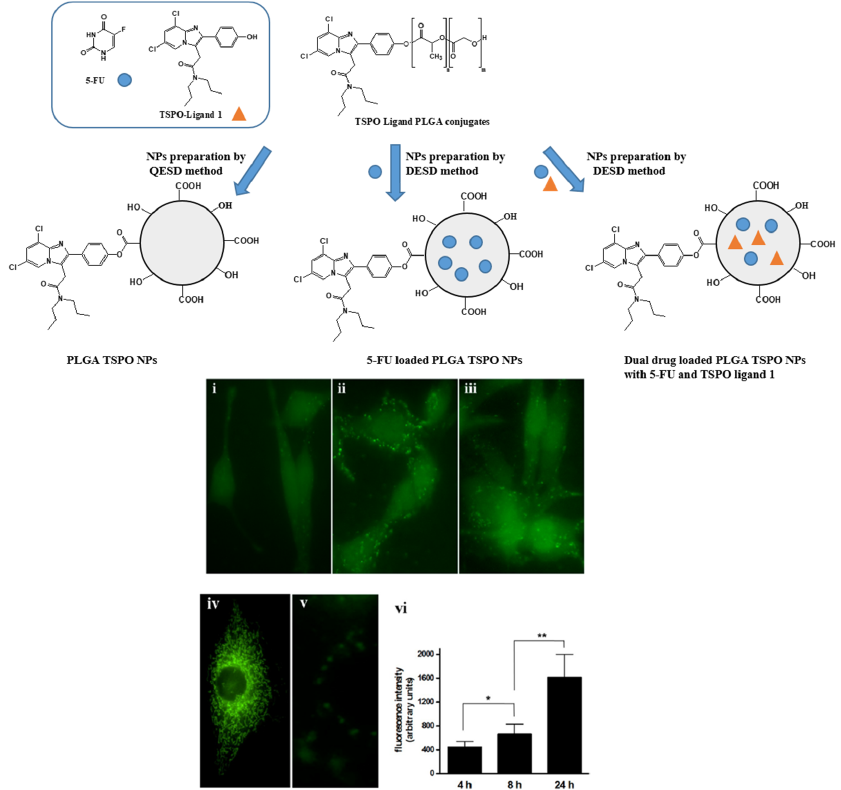
Figure 6. Upper panel shows a schematic representation of PLGA-TSPO NPs; bottom panel shows the fluo- rescence microscopy images: cells were seeded onto 24 mm coverslips and treated at 37 °C in a 5% CO 2 atmosphere with 0.2 µM FITC − TSPO NPs (concentration is referred to FITC). Internalized FITC fluorescence was acquired after 4 ( i ), 8 ( ii ), and 24 h ( iii ). Cells incubated with 25 nM MitoTracker Red CMXRos ( iv ) and cells treatment with FITC (7 µM) alone after 24 h ( v ) were used as the control. Average intensity of internal- ized fluorescence of treated cells as imaged after 4, 8, and 24 h of incubation ( vi ). Data are given as means ± SD (bars) for five separate cultures. The statistical significance of differences was calculated by the unpaired Student’s t test with Bonferroni’s correction. * p < 0.05, ** p < 0.005. Adapted with permission [34]. Copyright © 2021 American Chemical Society.